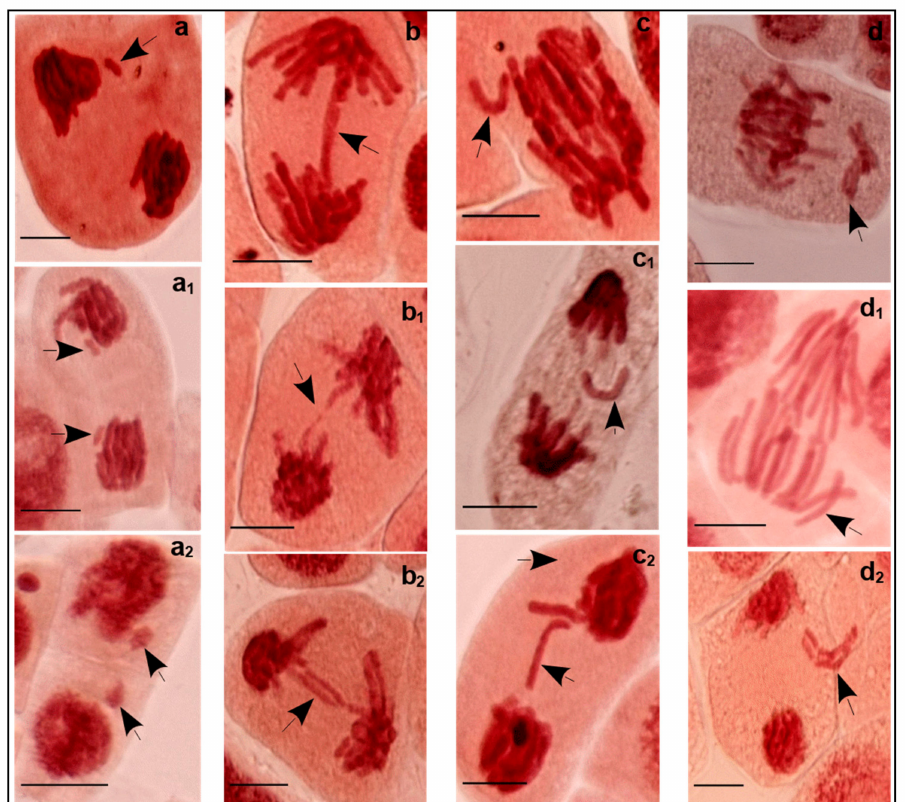
Figure 3. Structural and numerical anomalies found in V. faba cells in division exposed to C3 and C4 irrigation water samples. Structural aberrations include changes in structure of